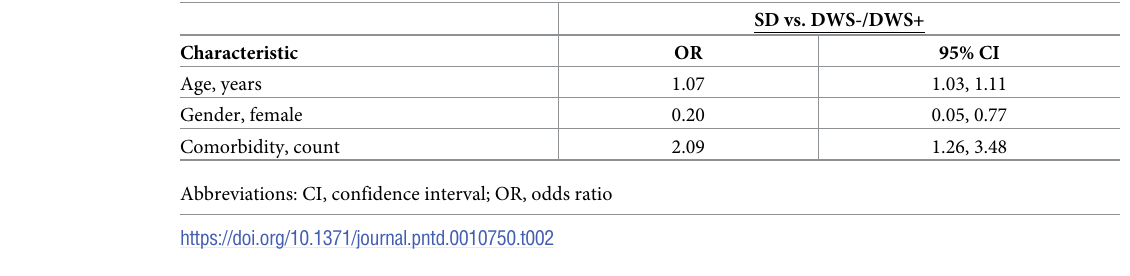
cases tested positive for DENV by rRT-PCR, and this did not differ between severity categories (Tables 1 and S1). The proportion of DWS-/DWS+ cases with detectable NS1 (77/122, 63.1%) was significantly lower than SD cases (21/23, 91.3%; p = 0.010). DENV-4 was the predominant type, present in 78.5% of the typed samples overall (102/130). Infections by Zika and chikun- gunya viruses were not detected, nor were coinfections by two DENV serotypes. Acute-phase samples were tested with two serologic tests: the pGOLD assay for anti-DENV and anti-ZIKV IgM and IgG, and a commercial ELISA for anti-DENV IgM and IgG (Tables 3 and S2). The proportion of individuals with detectable anti-DENV IgM was significantly higher with the pGOLD assay (p < 0.001, S3 Table). Although a smaller proportion of SD cases had detectable anti-DENV IgM compared to DWS-/DWS+ cases by either method, this Table 2. Binomial logistic regression of participant demographics and disease severity.